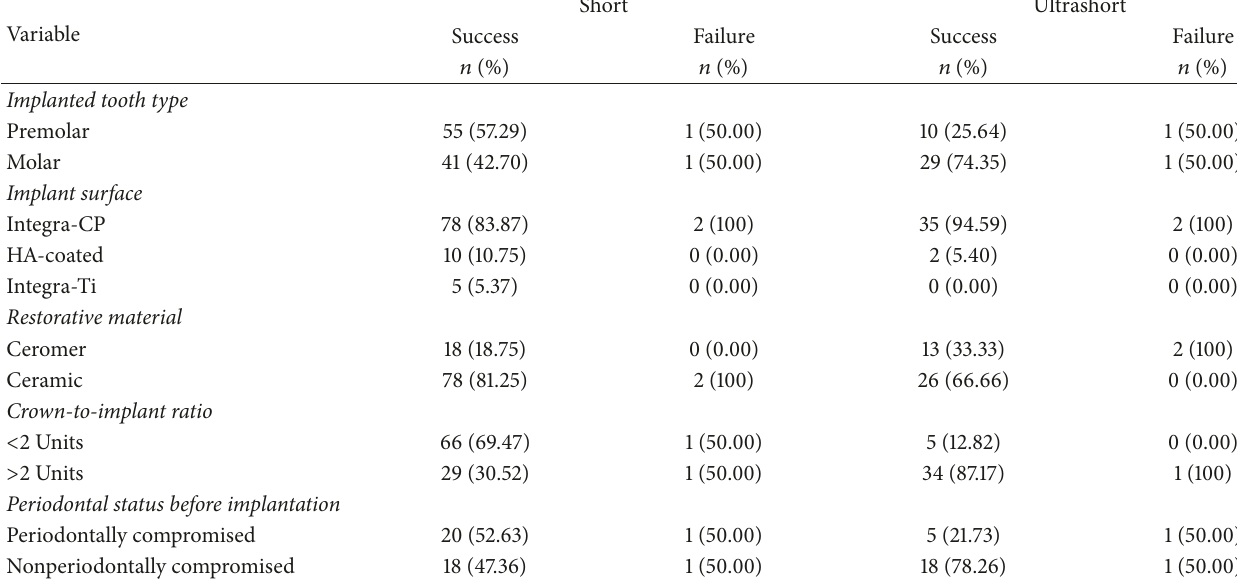
Table 3: Descriptive analysis of the success rate according to study